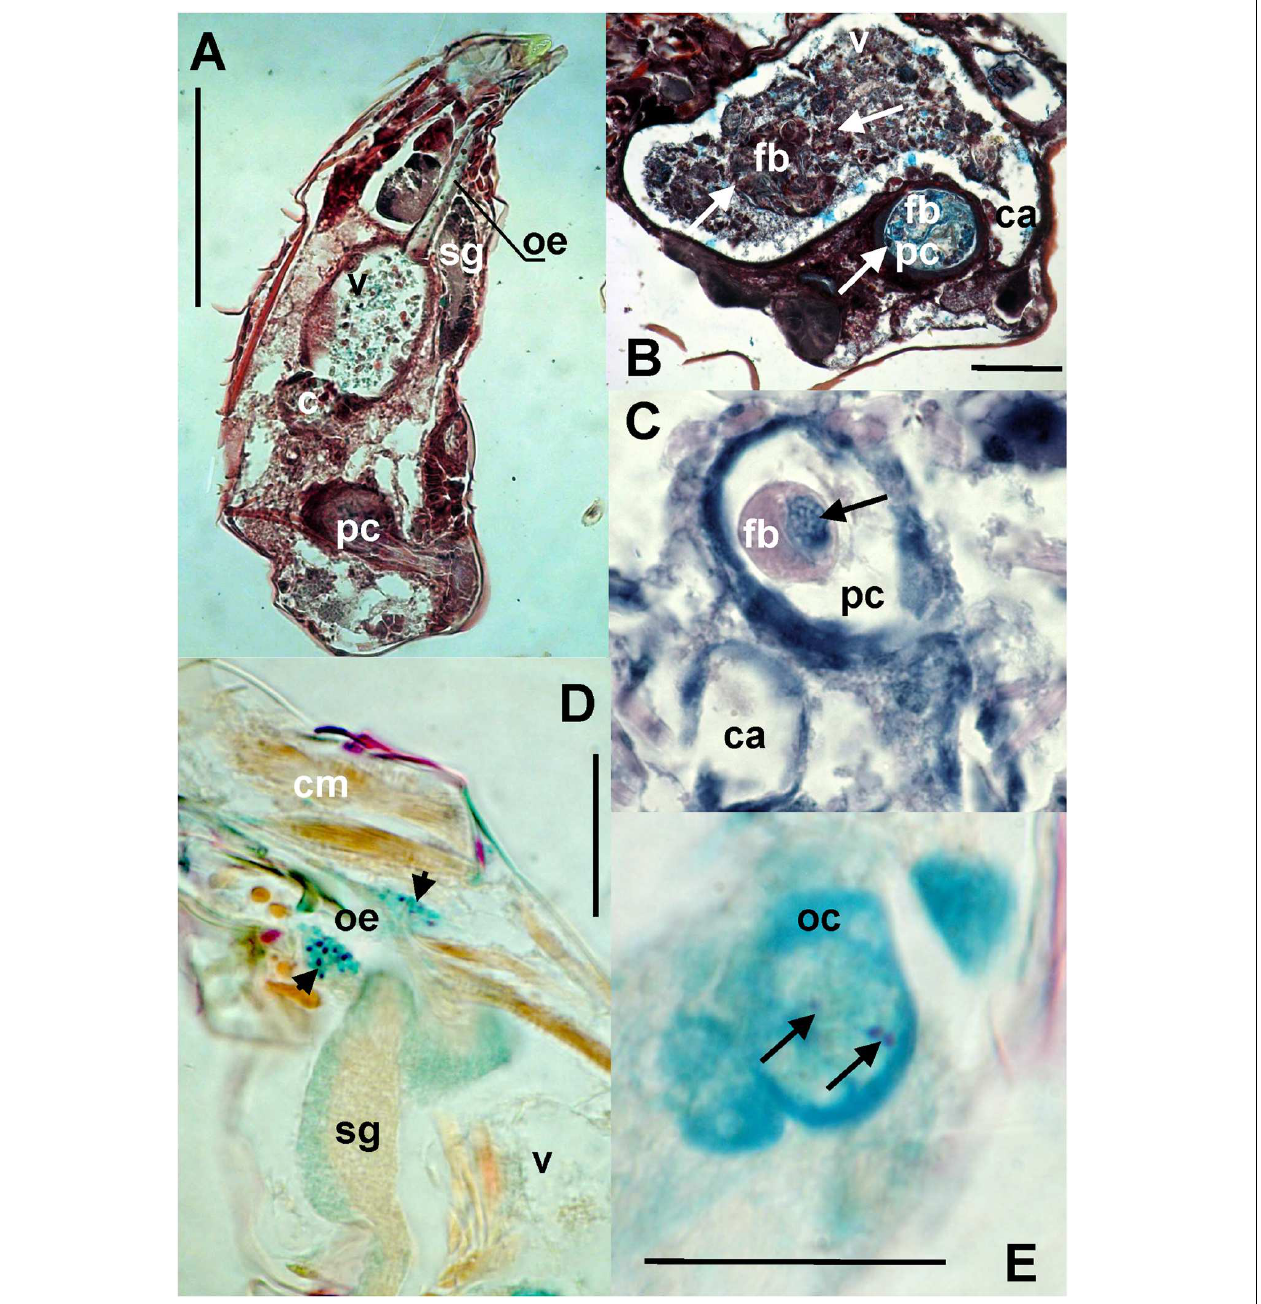
FIGURE 7 | The images show: (A) total view of the digestive tract of T. putrescentiae ; (B) total view of the ventriculus and post-colon with ingested food; arrows point to food boli; (C) detail view of the post-colon of specimens with food boli formed from mucoid substances and fragments of diet (arrow); (D) detail view of the salivary glands with stained bacterial cells (arrows); (E) detail view of oocyte with stained bacterial cells (arrows). Staining: (A,B) Masson’s triple stain, (C) Ziehl–Neelsen, (D,E) Mann Dominici; Scales: (A,B) 100 µ m, (D,E) 25 µ m. c, colon; ca, caecum; cm, cheliceral muscles; fb, food bolus; oc, oocyte; oe, esophagus; pc, post-colon; sg, synganglion; v, ventriculus.